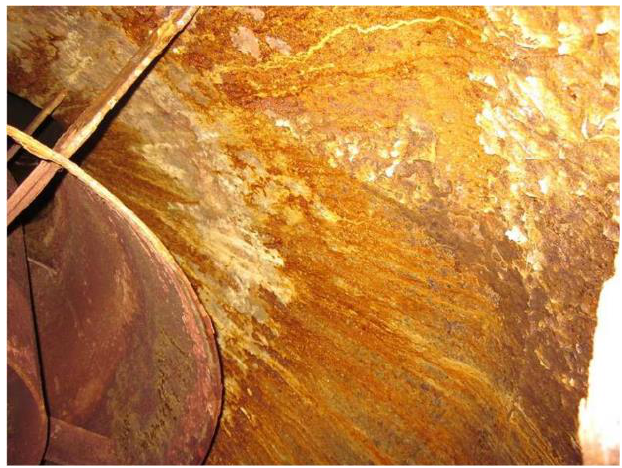
Figure 6. Sulfuric acid corrosion inside the pipeline [28]. During the normal operation of the SCR system, due to the introduction of urea solution, the generated ammonia gas and sulfuric acid vapor will condense into ammonium bisulfate and other substances as shown in Equation (8), causing the amount of sulfuric acid vapor before and after the reactor to be lower [57].